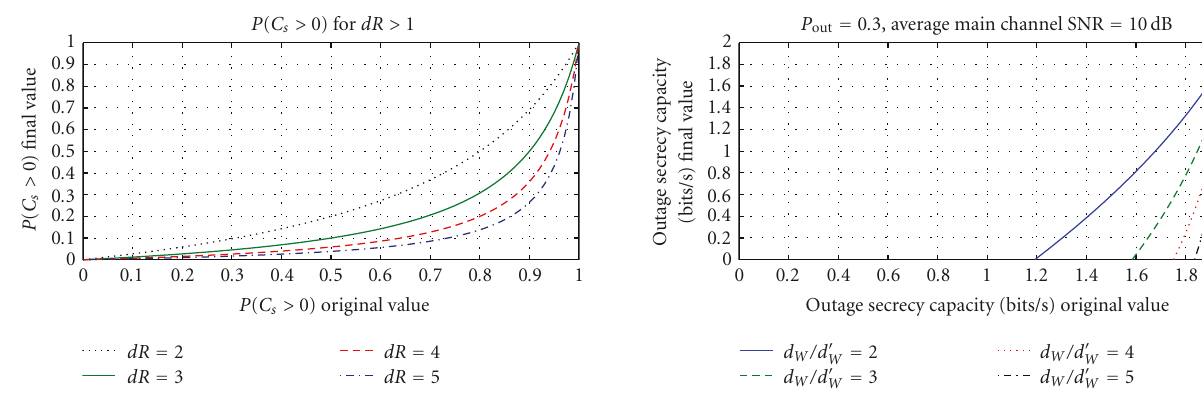
Figure 1: Probability of Nonzero Secrecy Capacity for DRF > 1. Figure 2: Outage Secrecy Capacity before and after eavesdropper’s